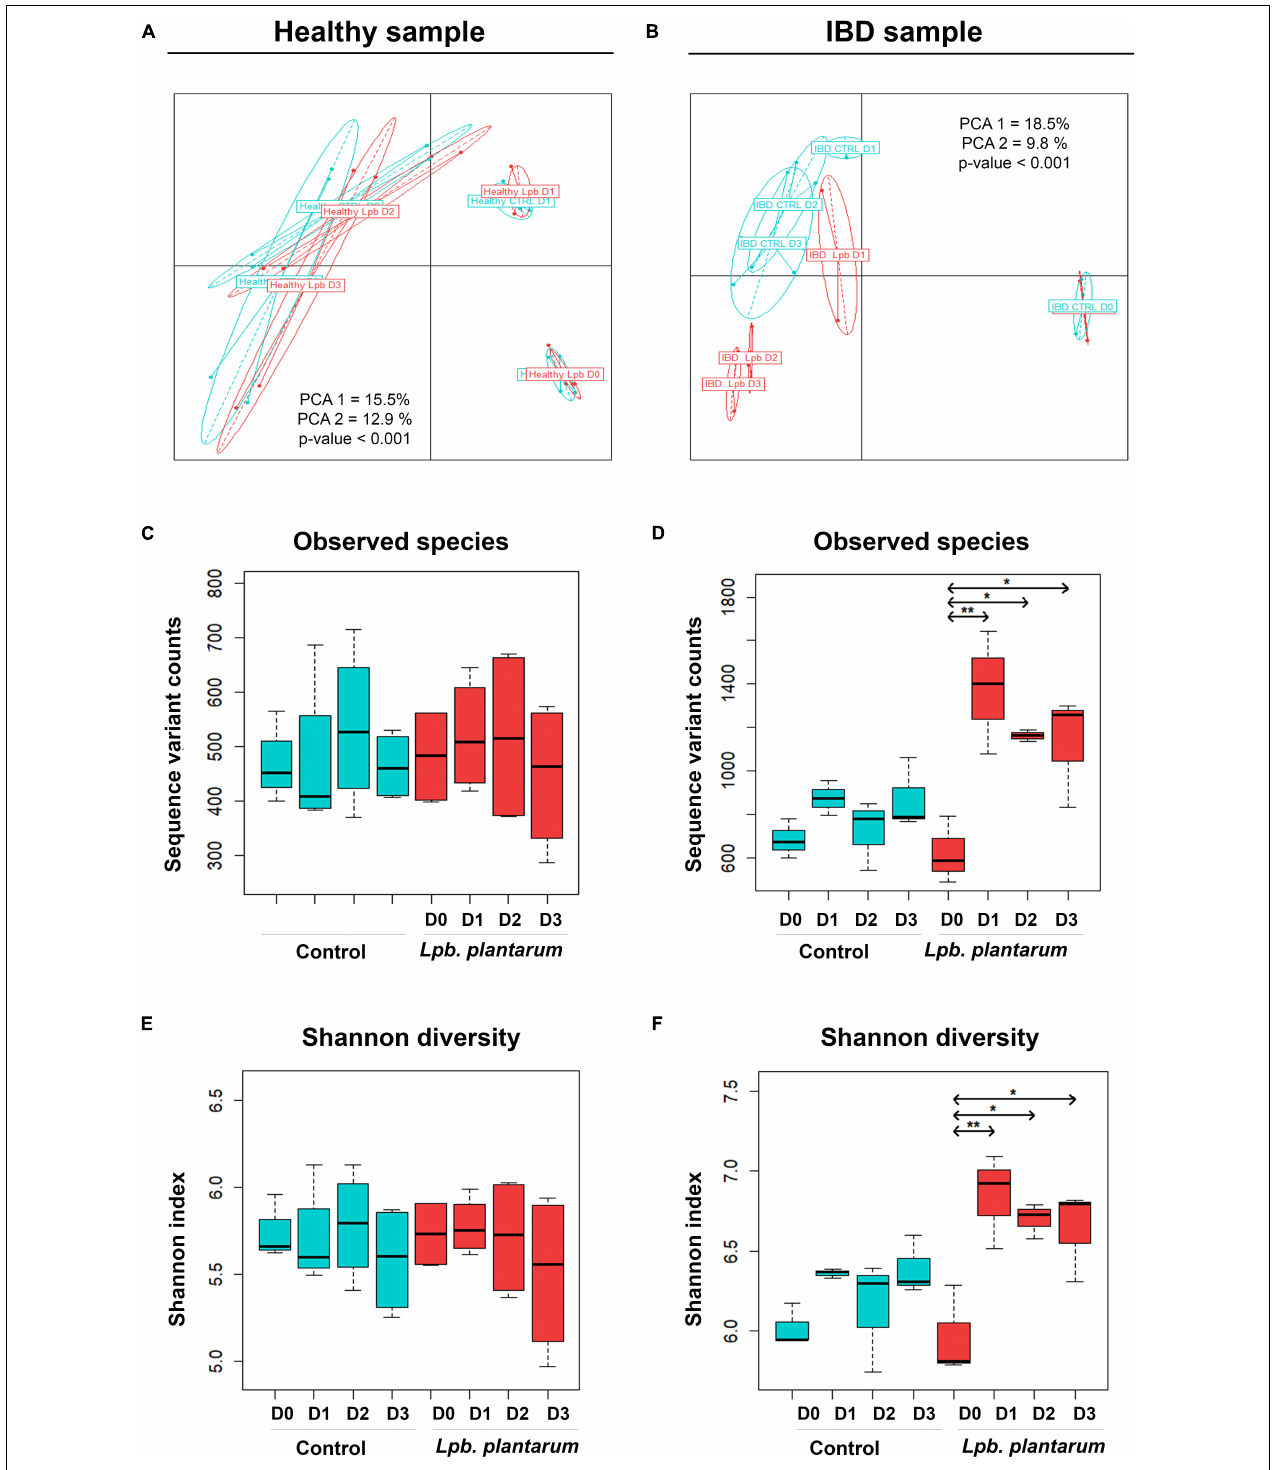
FIGURE 1 | Bray–Curtis PCoA of Lpb. plantarum probiotic effect on model gut microbial β -diversity of a healthy individual (A) and an IBD patient (B) . The Bray–Curtis index was used on sequence variant counts (from DADA2), and groups represent samples taken over a period of 4 days (from D0 to D3); for the control (blue) and Lpb. plantarum -inoculated (red) intestinal microbiota. PCA1 and PCA2 represent the percent of variation explained by principal coordinate axes 1 and 2, respectively. The p -value is the result of an ANOVA test on a Bray–Curtis distance matrix. Lpb. plantarum effect on model gut microbial diversity of a healthy individual (C , E) and an IBD patient (D,F) . Alpha diversity is based on the number of observed species (C,D) and Shannon index (E,F) . Box plots show diversity over a period of 4 days (from D0 to D3). Experiments were carried out in triplicate with the IBD sample and in quadruplicate with the healthy sample. * p < 0.05, ** p < 0.01.